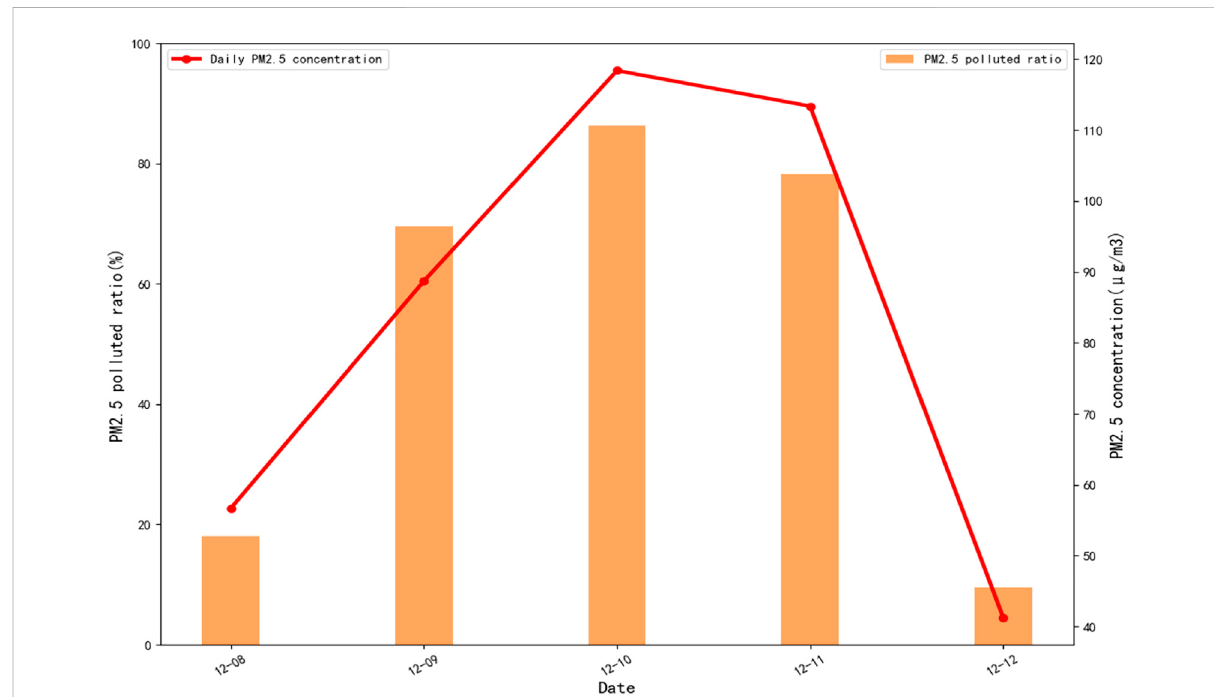
FIGURE 10 Daily PM 2.5 concentrations and PM 2.5 pollution ratios from December 8 to 12 of 2021 in BTH and its surrounding